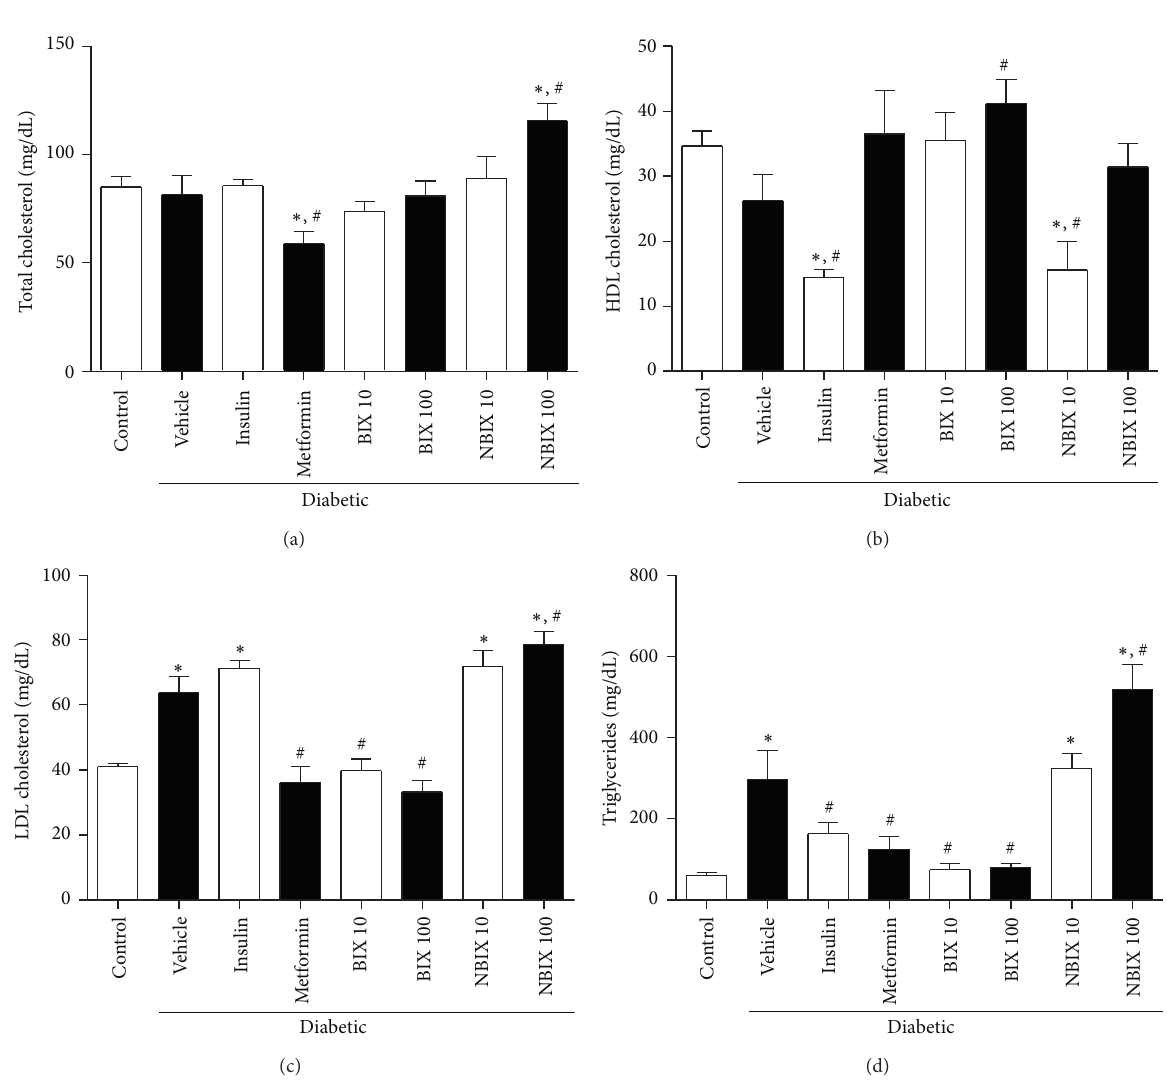
Figure 3: Lipid profileof streptozotocin-induced diabetic rats: total cholesterol (a), HDL cholesterol (b),LDL cholesterol (c), and triglycerides (d). Data are expressed as means ± SEM ( 𝑛 = 6 per group). ANOVA followed by Duncan’s test: ∗ 𝑃 < 0.05 versus nondiabetic control; # 𝑃 < 0.05 versus diabetic vehicle. BIX 10: 10mg/kg bixin; BIX 100: 100mg/kg bixin; NBIX 10:10 mg/kg norbixin; NBIX 100: 100mg/kg